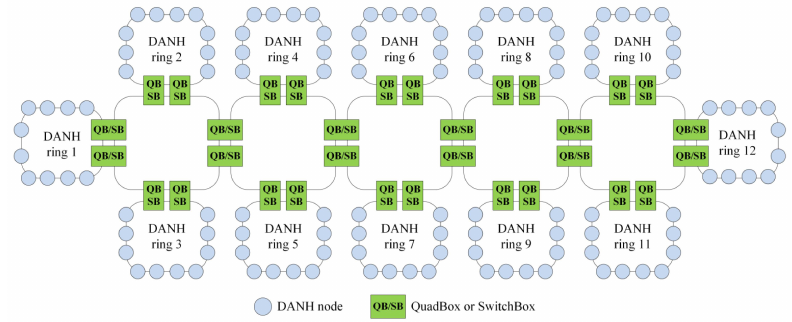
Figure 24. The sample HSR network in case 1 of Simulation 3.